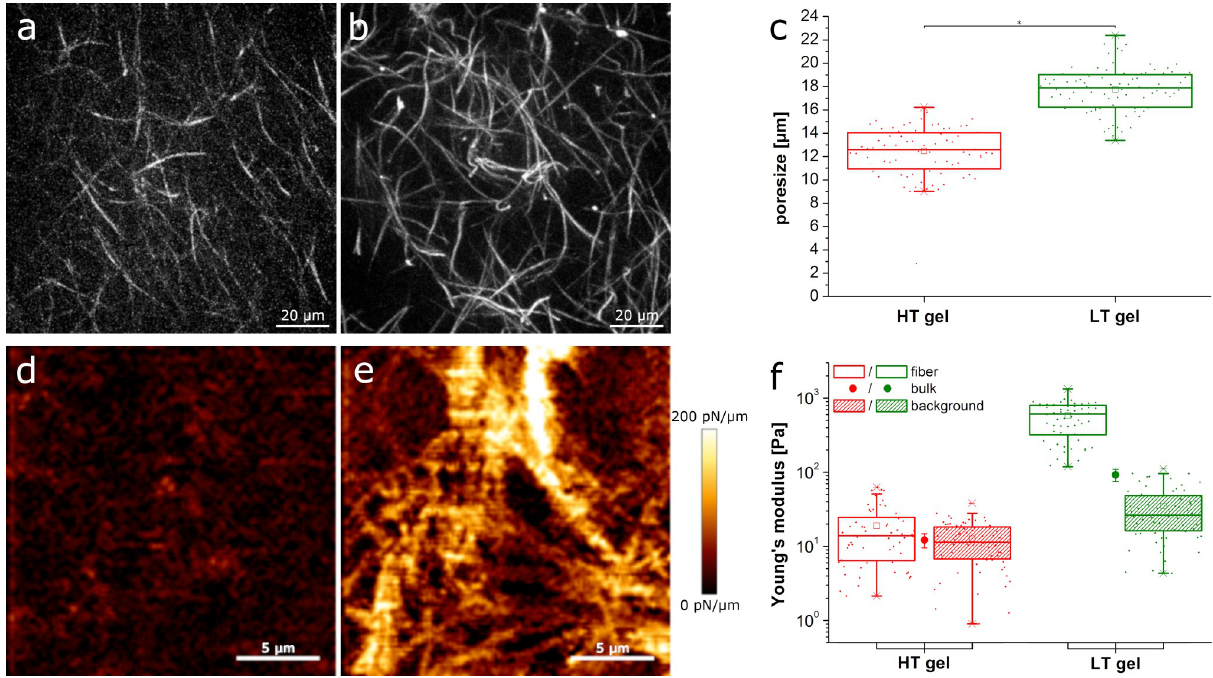
Fig 1. Collagen gel characterization. a) Fluorescence image of an HT gel polymerized at 37˚C and b) of a LT gel polymerized at lower temperatures; c) pore sizes of HT and LT gels respectively (p < 0.001, two-sample t-test); AFM image proportional to the local stiffness of d) an HT and e) an LT gel; f) Young’s modulus of fibers and background as measured by AFM and Young’s modulus of the bulk gel as measured with a rheometer for HT and LT gels respectively.